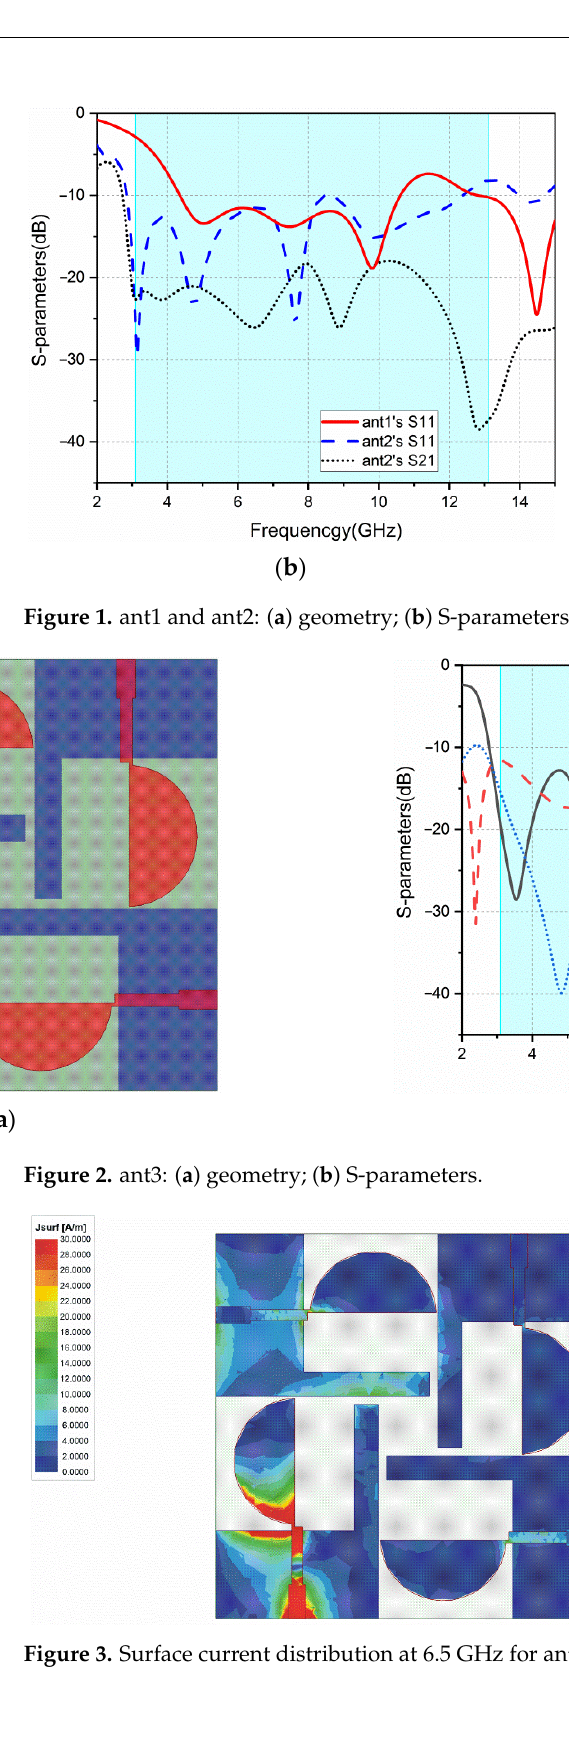
( b ) Figure 4. ant4: ( a ) geometry; ( b ) S-parameters. To further improve the isolation, a “ 卍 ” structure is introduced on the metal ground side, as shown in Figure 5a. This generates ant5. It can be seen in Figure 5b, after adding this structure, that the isolation between adjacent elements is significantly improved. This is because the magnitude of mutual coupling currents generated between adjacent elements is the same, while their directions are opposite. They offset each other after passing through the “ 卍 ” structure. Besides, the structure also improves the impedance matching of the antenna, and produces a better return loss.